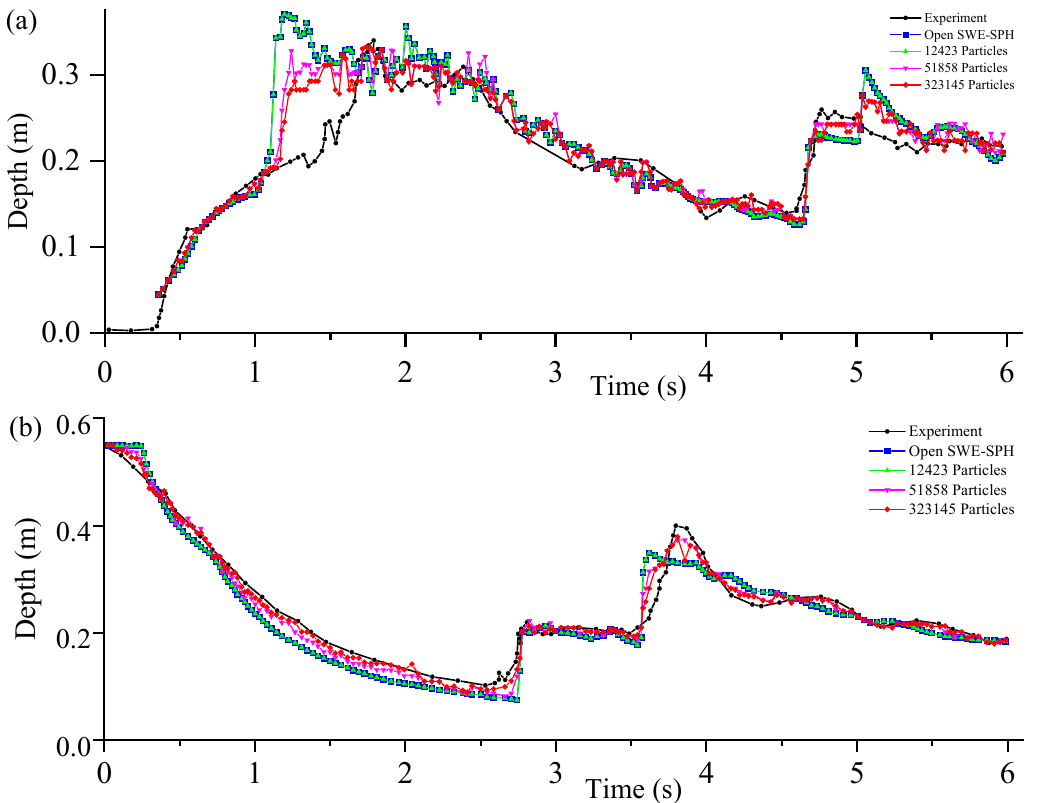
Figure 15. Comparison between experimental and numerical results water depth datasets: ( a ) gauge H4 in [2] and [80]; ( b ) gauge H2 in [2] and [80].